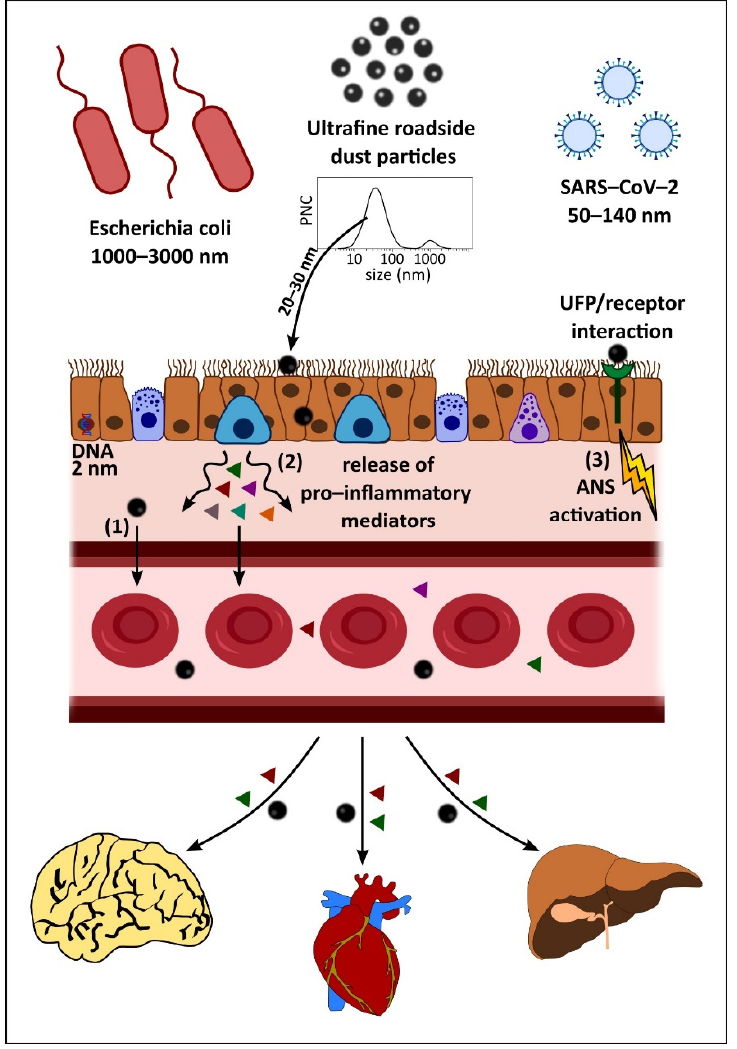
Figure 1. Fate of inhaled ultrafine road-deposited dust particles (UF-RDPs) in the human body. Inhalation of UF-RDPs may occur when settled road-deposited dust (RD) particles become aerosolised due to wind conditions and/or traffic movement. RD contains a range of particle sizes as shown by the particle number concentration (PNC) graph (adapted from [12]). UFPs can become trapped in mucus or by cilia lining the airway epithelium but very small particles (~20–30 nm) may penetrate between and/or through cells. Such incursion is usually impeded by tight junctions between neighbouring cells, but these junctions can become damaged, and/or UFPs may increase paracellular permeability temporarily, allowing for transient opening of tight junctions and passage of particles [41]. UFPs may also pass transcellularly, travelling through epithelial cells lining the lungs, and can interact/damage cellular components during this passage [42]. The impact of UFP inhalation is not limited to the lungs but extends systemically via three possible mechanisms [43]: 1. incursion into the circulatory system, with subsequent travel to and deposition in